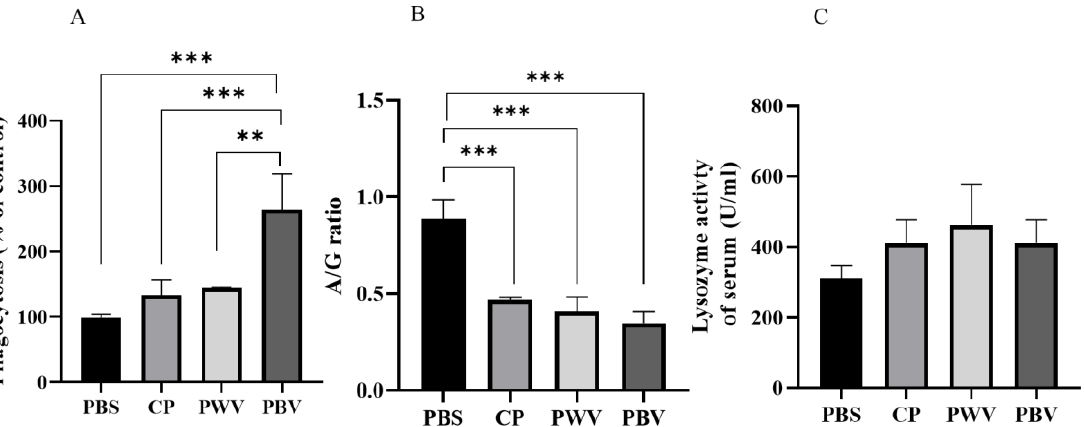
Figure 3. Phagocytosis ( A ), A/G ratio ( B ), and lysozyme activity ( C ) of giant grouper at 28 days post-vaccination. Data are presented as mean ± SD ( n = 4). p -values were calculated by one-way ANOVA ( p < 0.01 **, p < 0.001 ***). PBS: commercial feed with PBS. CP: commercial feed with chitosan particle. PWV: commercial feed with whole-cell vaccine. PBV: commercial feed with biofilm vaccine.